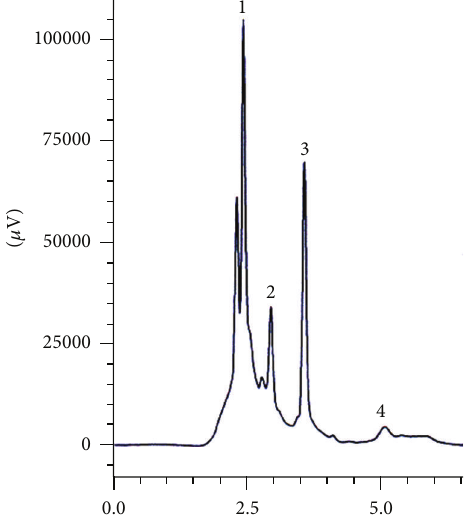
Figure 4: HPLC analysis of methanolic extract of A. nilotica (1 = tannic acid, 2 = gallic acid, 3 = catechin, and 4 = hesperidin).